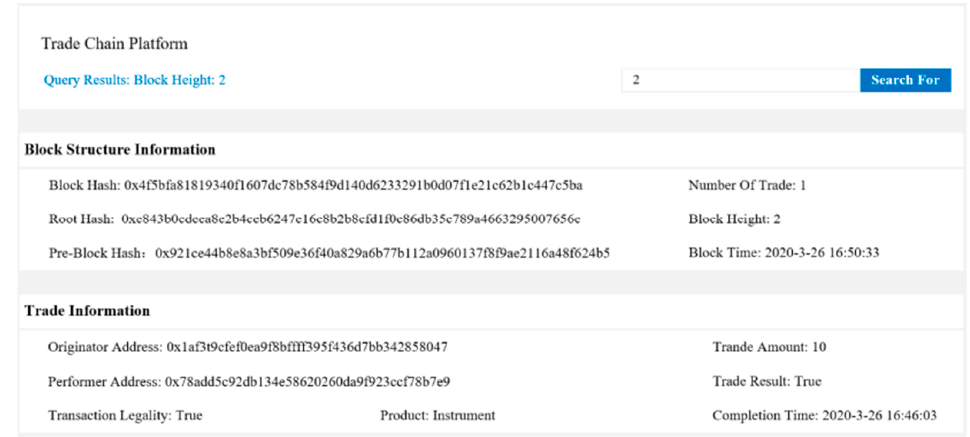
Figure 10. Trading block information.